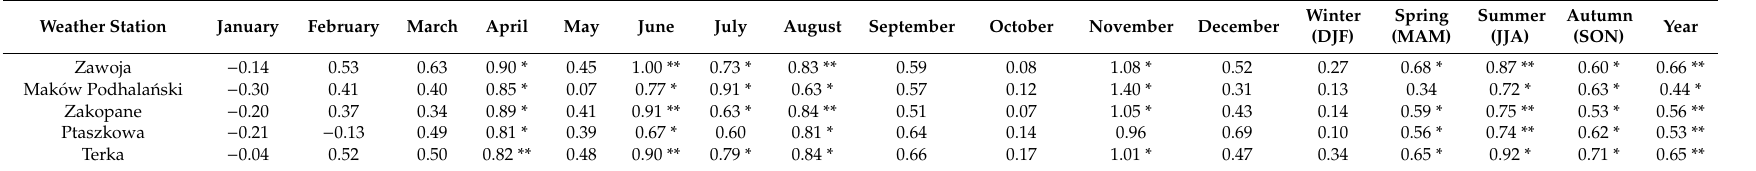
Table 5. Trend intensity ( ◦ C per decade) in maximum air temperature (TAmax) for each month, each season (1984–2018) and for the annual means (the last column). Weather